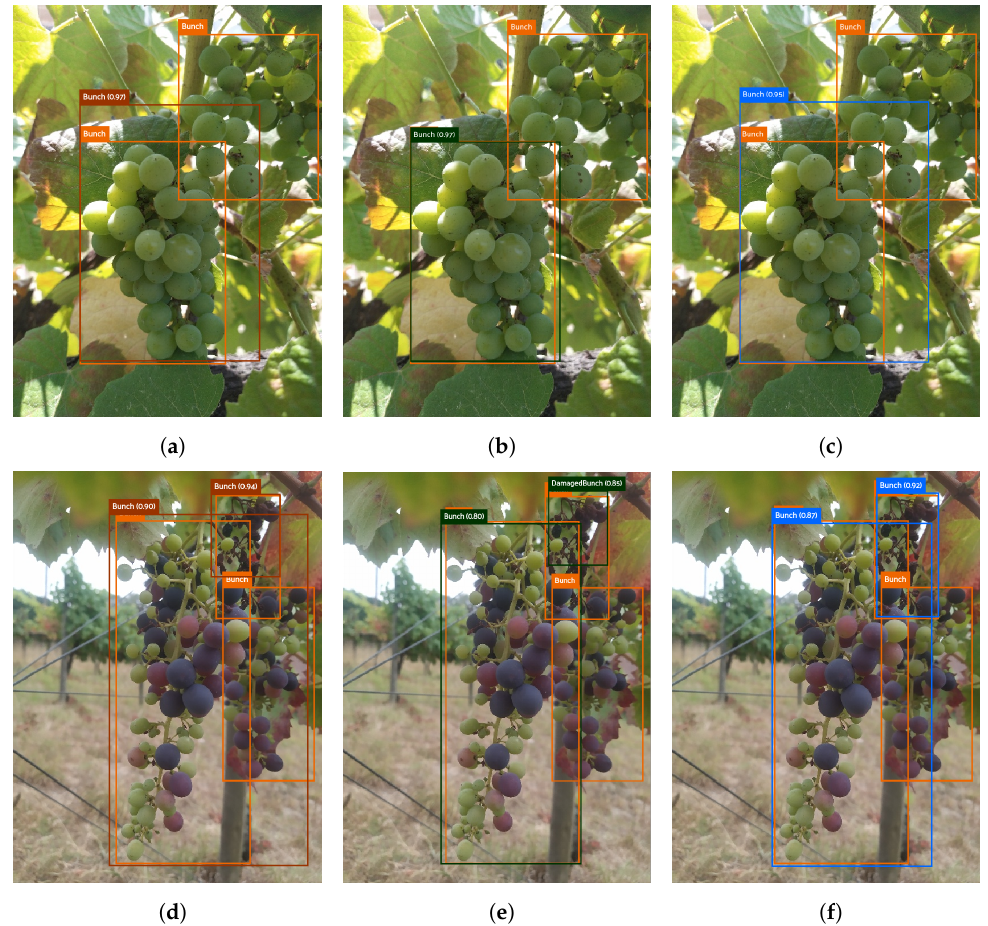
Figure 6. FNs in samples from the test set. Orange bounding boxes present ground truth. Red bound- ing boxes present the predictions from YOLOv5. Green bounding boxes present the predictions from YOLOv7. Blue bounding boxes present the predictions from YOLOR. ( a ) Example 1—YOLOv5. ( b ) Ex-